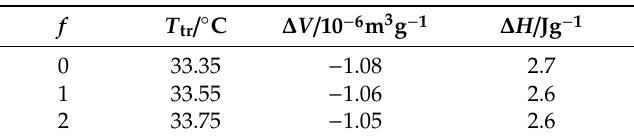
Table 1. Force in the number of metal weight ( f ), transition temperature ( T tr ), volume change of gel specimen per unit mass of polymer network ( ∆ V ) and transition enthalpy per unit mass of polymer network ( ∆ H ).